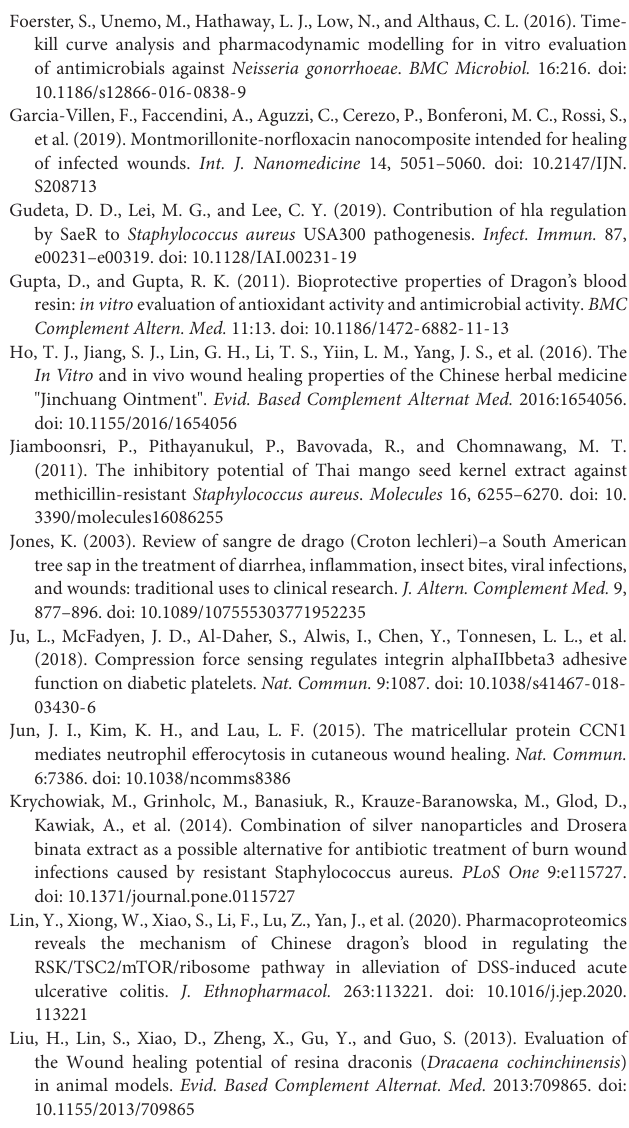
Supplementary Table 1 | Patient clinical data and characteristics of 6 clinical S. aureus